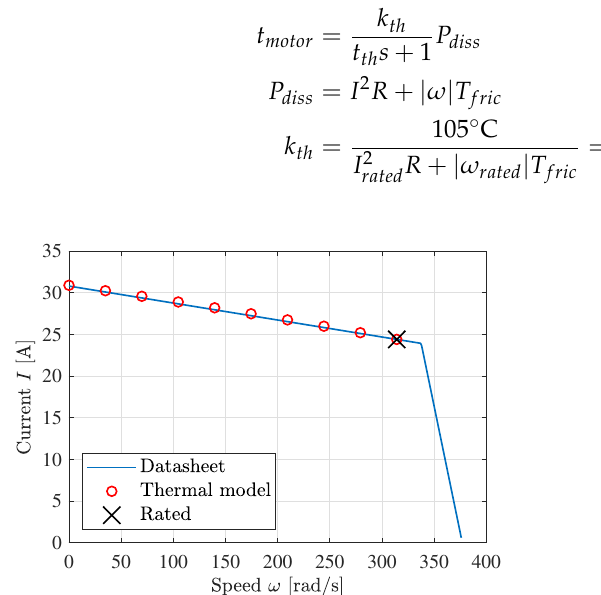
Figure 20. Allowable continuous current to stay below 105 ◦ C.